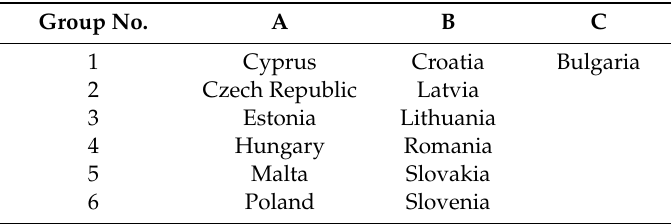
Table 5. Clusters for IRE in 2004.